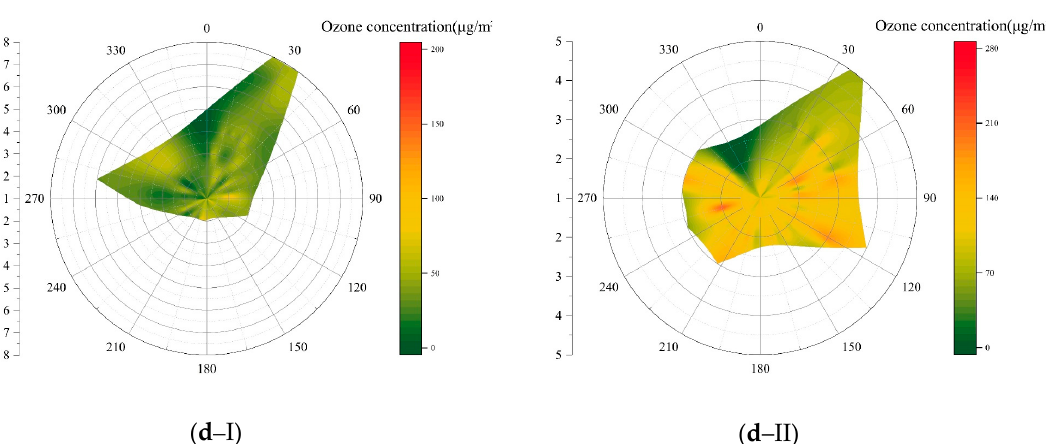
Figure 8. Wind direction, frequency and ozone concentrations at 2 am and 2 pm for typical coastal and inland cities of Shandong province in 2018 (( a ) WH; ( b ) YT; ( c ) JNA; ( d ) LY; I, 2 am; II, 2 pm).